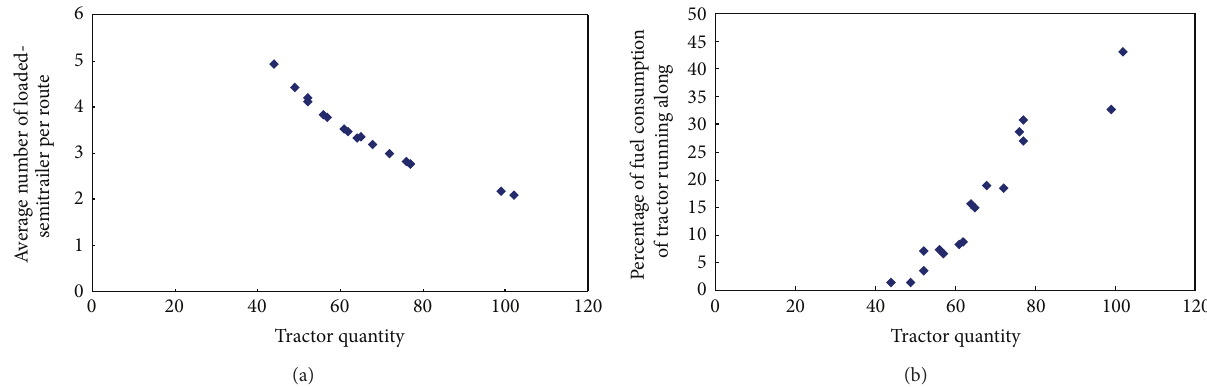
Figure 2: In the SA results, (a) the relationship between the tractor quantity and the average loaded-semitrailer number of a route; (b) the relationship between the tractor quantity and the percentage of fuel consumption for tractor running